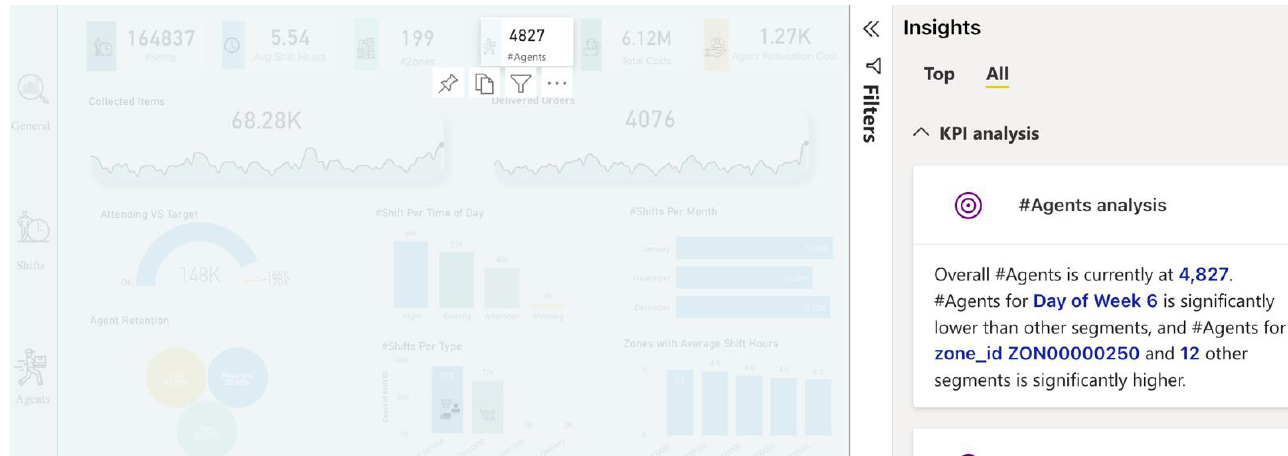
Figure 14. Auto-generated insights from the dashboard in the AA approach.